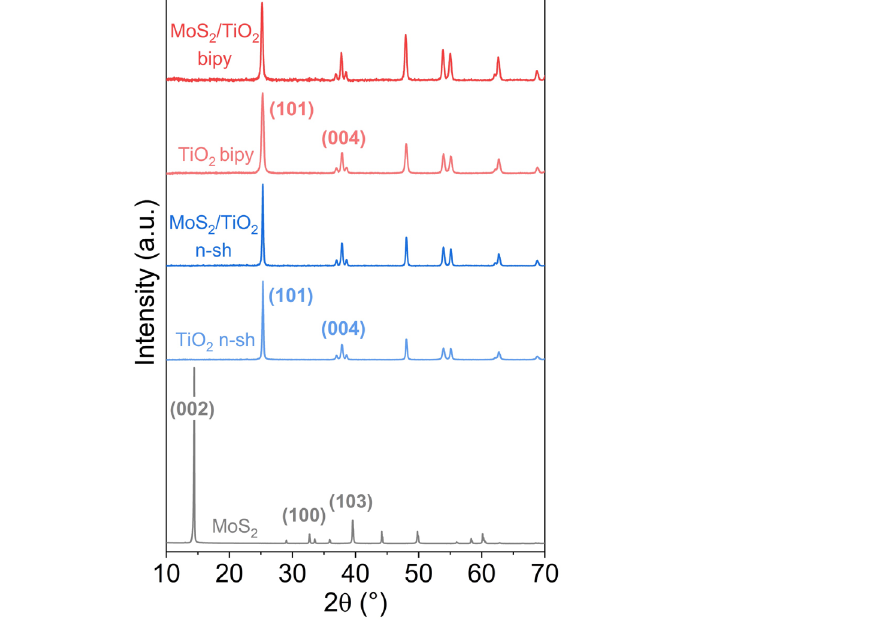
Figure 1. XRD patterns of: MoS 2 /TiO 2 bipy (red line), TiO 2 bipy (light red line), MoS 2 /TiO 2 n-sh (blue line), TiO 2 n-sh (light blue line), and MoS 2 (grey line). Owing to the different orientations with respect to the copper grid, the particles show different contours, due to the random arrangement of the nanocrystals, characterized by prevailing basal (001) faces (Figure 2a) or lateral (101) faces (Figures 2c and S1). From the TEM image in Figure 2a, MoS 2 /TiO 2 n-sh expose basal faces in the 30–100 nm range, with thicknesses of about 20–30 nm, as obtained from the image contrast. As far as MoS 2 /TiO 2 bipy are concerned, TEM images are shown in Figure 2c. In this figure, truncated bipyramids are 10 nm wide in the basal plane and in the 25–45 nm range along the elongation direction. From particle size analysis, information on the lateral sizes of the TiO 2 -n sh (20–100 nm wide) and TiO 2 bipy (25–45 nm wide) can be obtained at first (gray histograms in Figure 2b,d), in agreement with the TEM images (Figure 2a,c). Some more MoS 2 stacking orders of 3 ± 2 layers come from both systems (yellow histograms in Figure 2b,d), which confirms the effectiveness of the in situ growth in obtaining thinner but even more defective MoS 2 slabs (see later in Figure 3a,b), as compared to other syn- thesis methods [46]. Despite the low magnification of the TEM images shown in Figure 2a,c, a few curved features decorating the anatase-shaped structures can be noticed (black arrows in figures). Highlighted also in the following HRTEM images (Figure 3a,b), we can ascribe the observed features to interference fringes of MoS 2 layers or dots covering the TiO 2 n-sh and TiO 2 bipy facets.